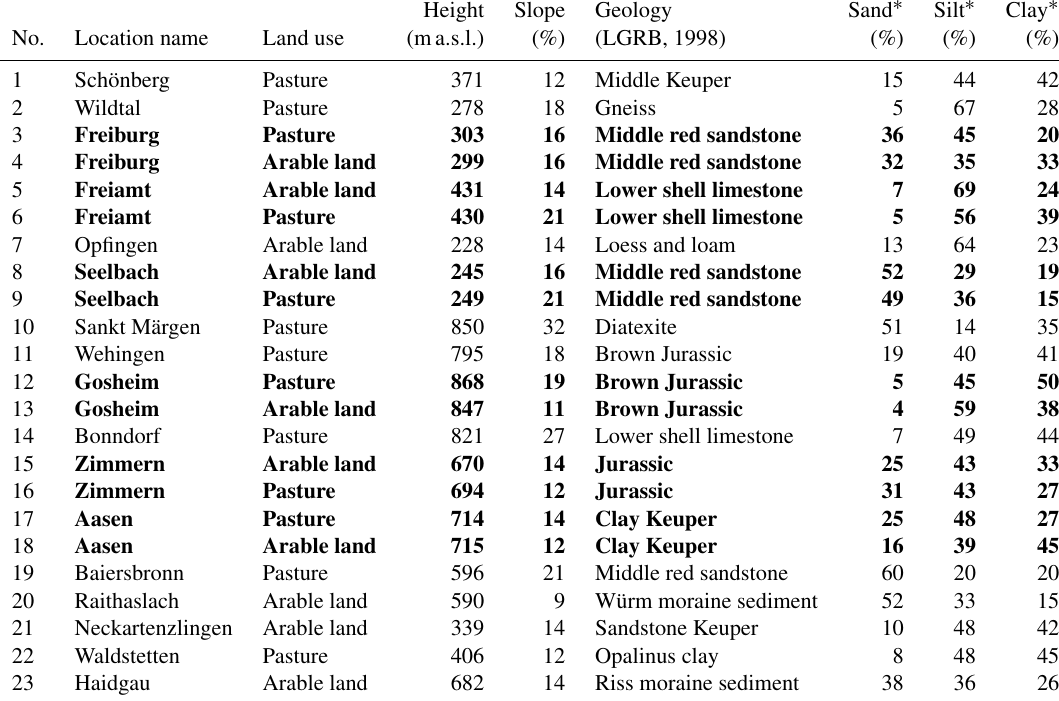
Table 1. Site characteristics of the experimental